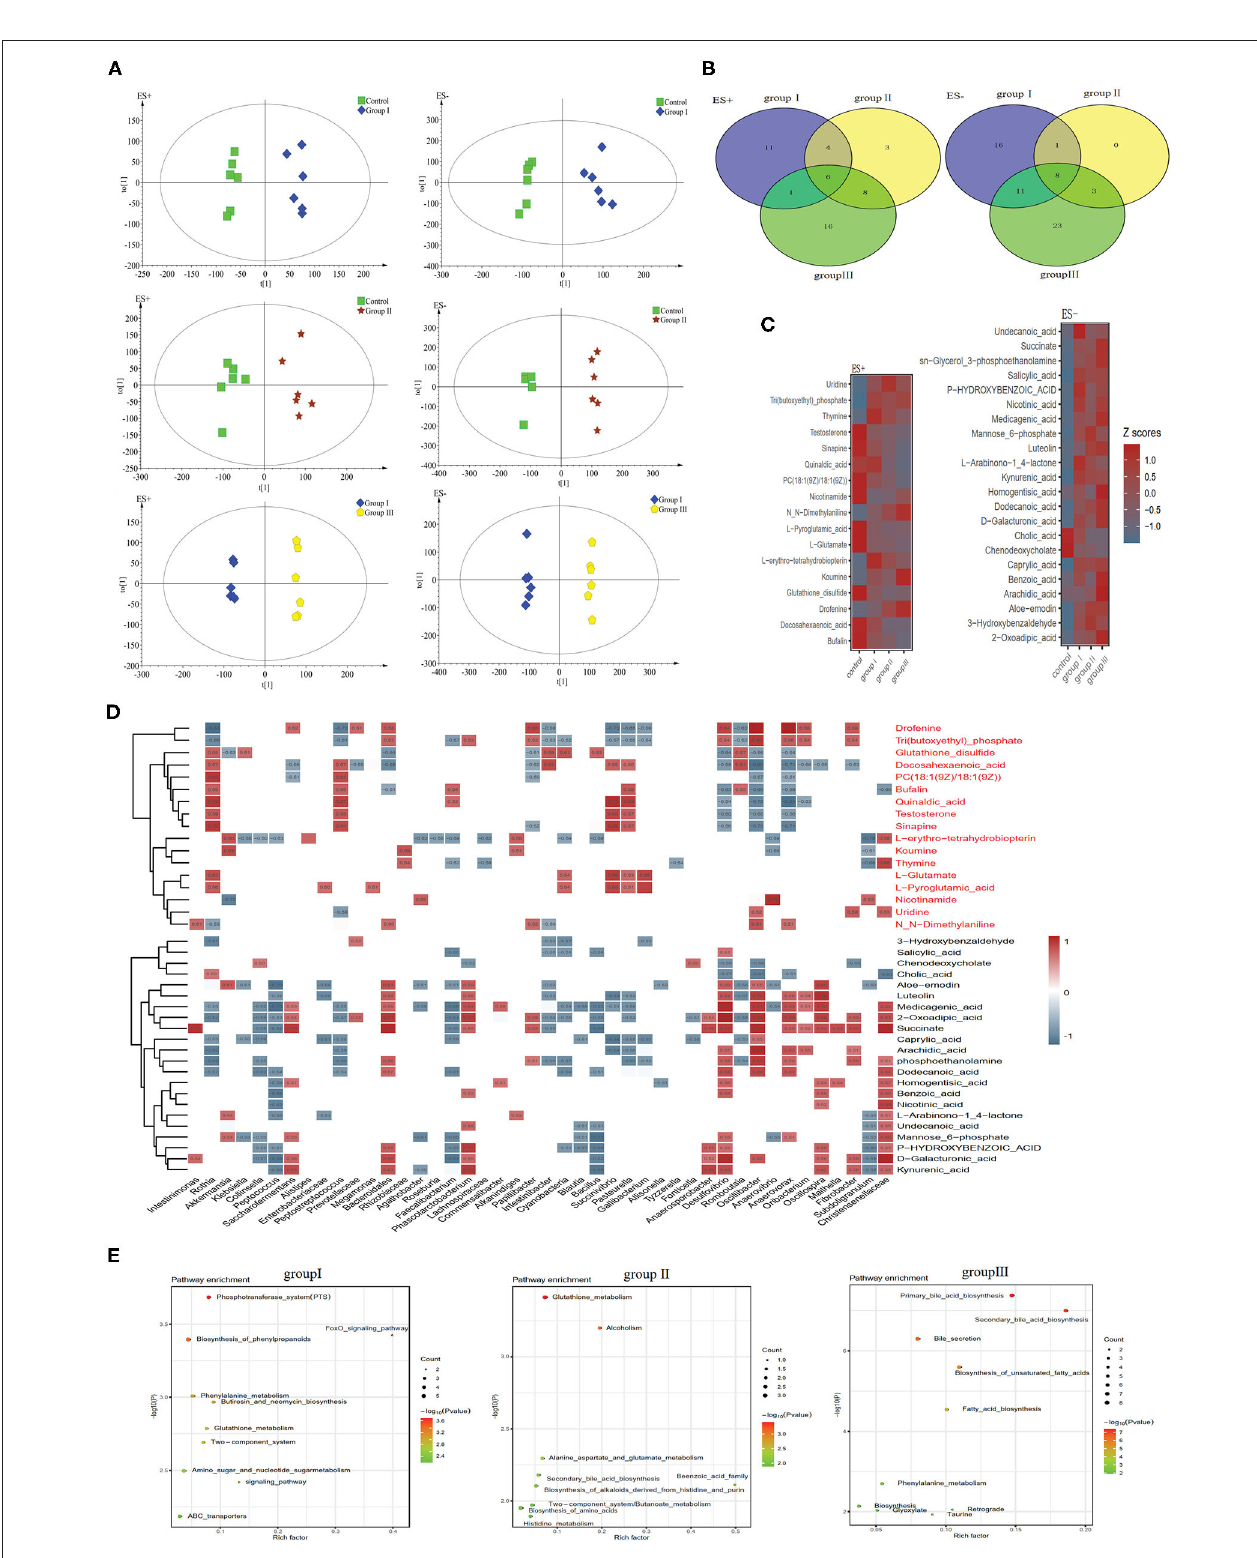
FIGURE 7 | Different metabolic patterns in group I, group II, and group III. (A) Score scatter plots of OPLS-DA comparing the metabolic differences identify the separation between group I and control, group II and control, and group III and control, respectively. (B) Metabolites that are significantly changed in group I, group II, or group III compared to the control at VIP > 1 and p value (t test) < 0.05 are identified. Venn diagrams demonstrate the number of altered metabolites shared among